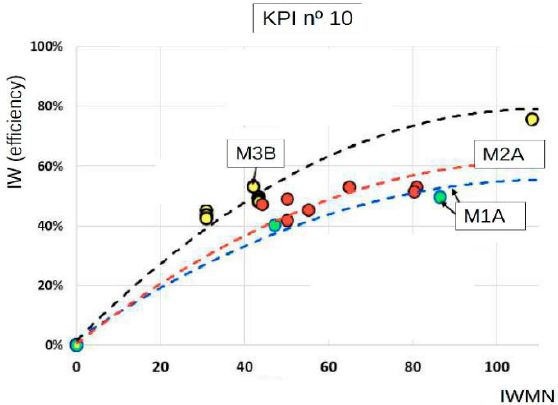
Figure 12. Graph of the values of KPI N° 10 (efficiency) corresponding to the machines whose data were analyzed. were